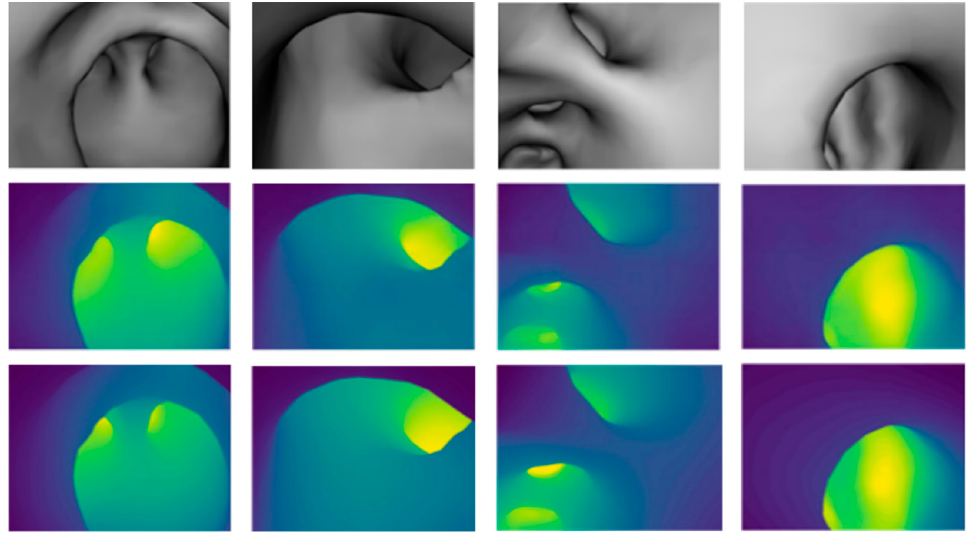
Table 3. Comparison of model depth prediction results under different loss functions.